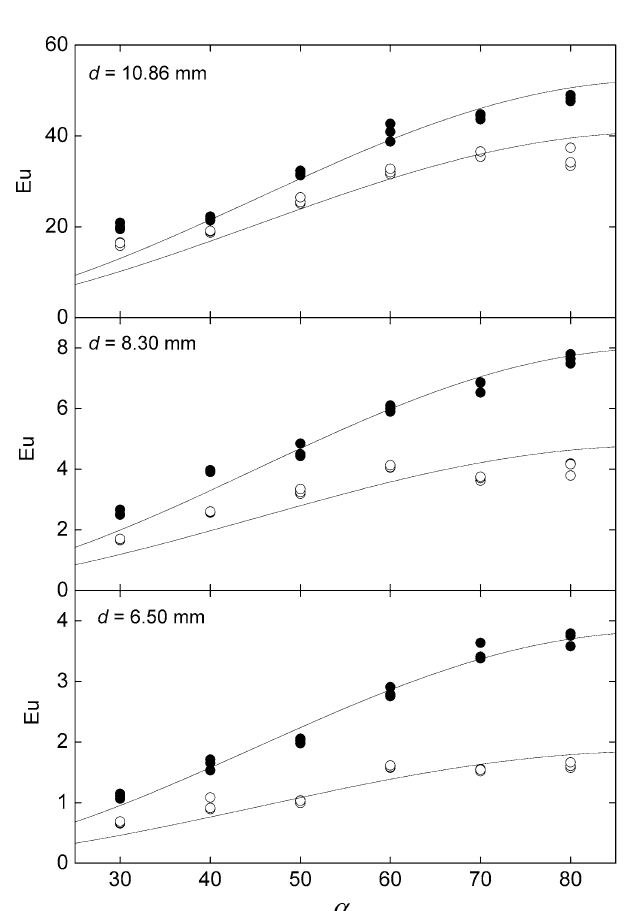
Figure 6. Variation of the wall Euler number, at θ = 180 o (full symbols) and the exit, (empty symbols) with the inclination angle. The curves corresponds to the independence principle, i.e. , Eu ∝ sin 5.4, www. gnupl ot.